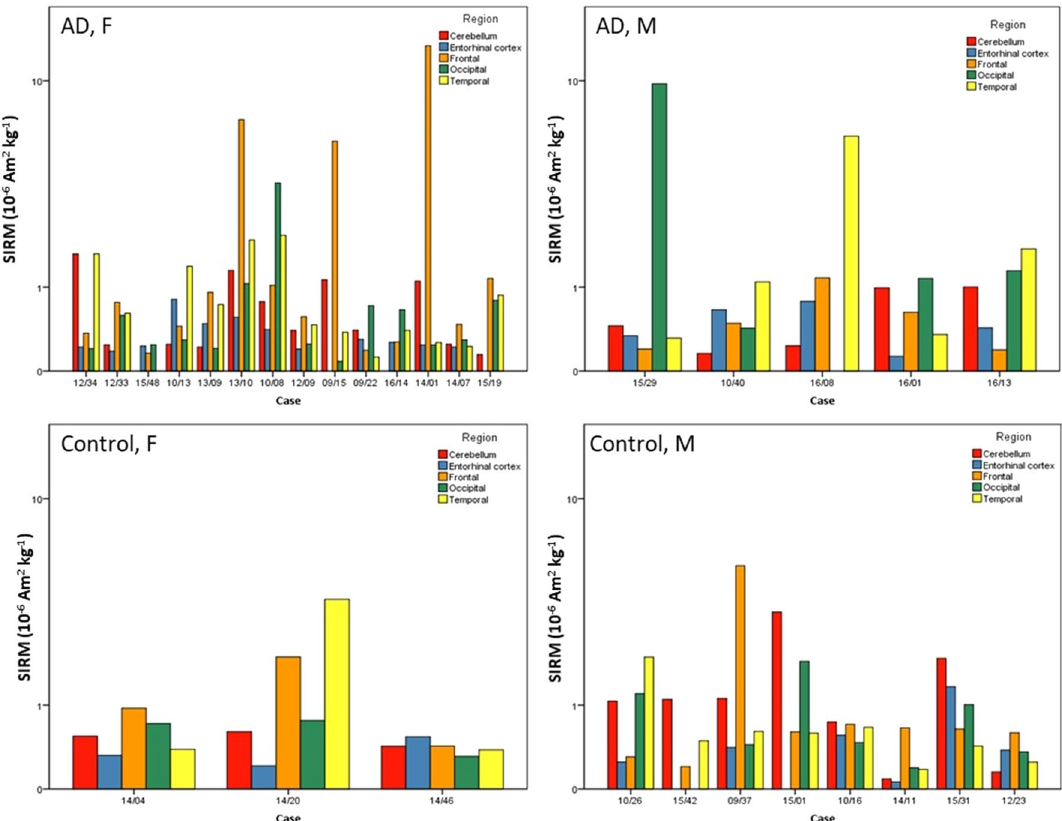
Figure 2. Regional distribution of mass-normalised SIRM values for human Alzheimer’s disease (AD) and control brains from Manchester Brain Bank, UK. Cases are arranged in each panel by ascending age (80– 98 years) and split by sex (F = female, M =